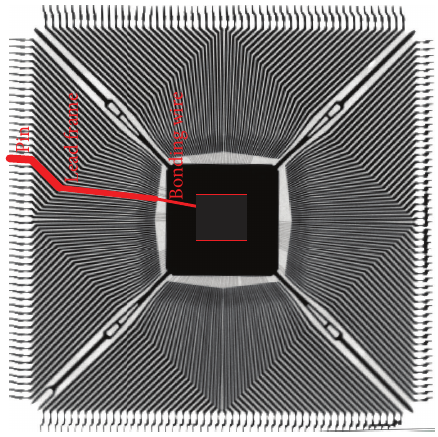
Figure 3: Clock divider block and function.